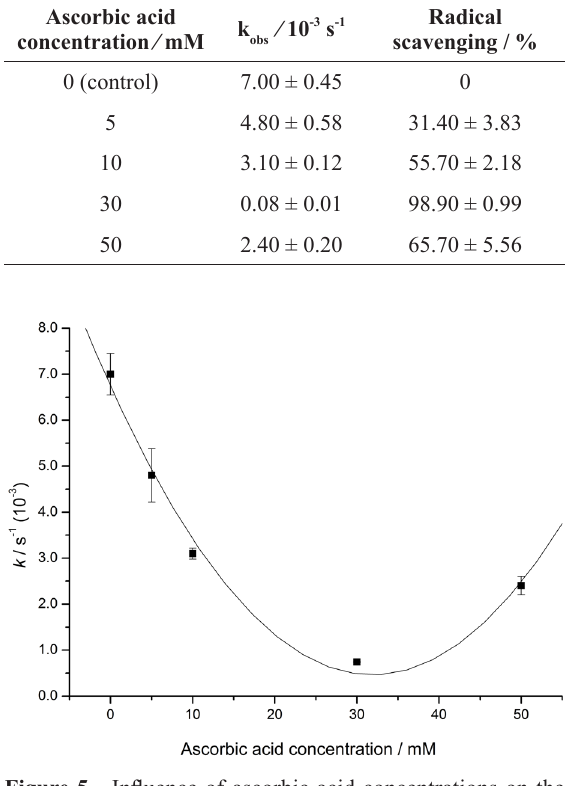
Figure 5 - influence of ascorbic acid concentrations on the pseudo-first order kinetic constants. error bars are related to experiments in triplicate.